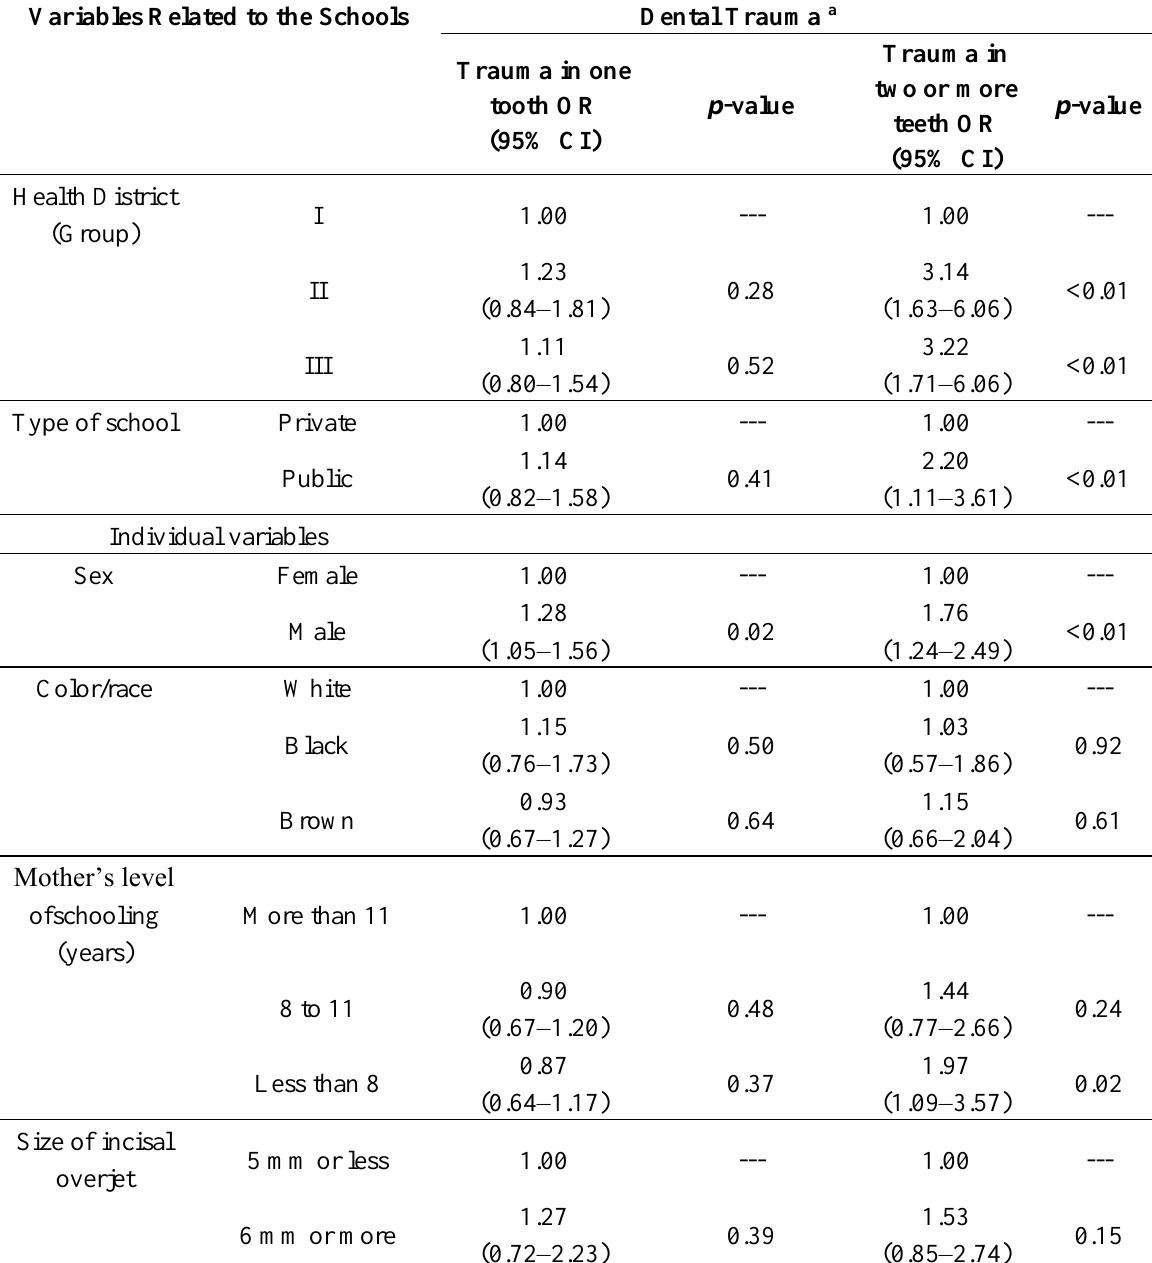
Table 2. Non-adjusted multinomial logistic regression analysis for the association between untreated dental trauma and individual and school related